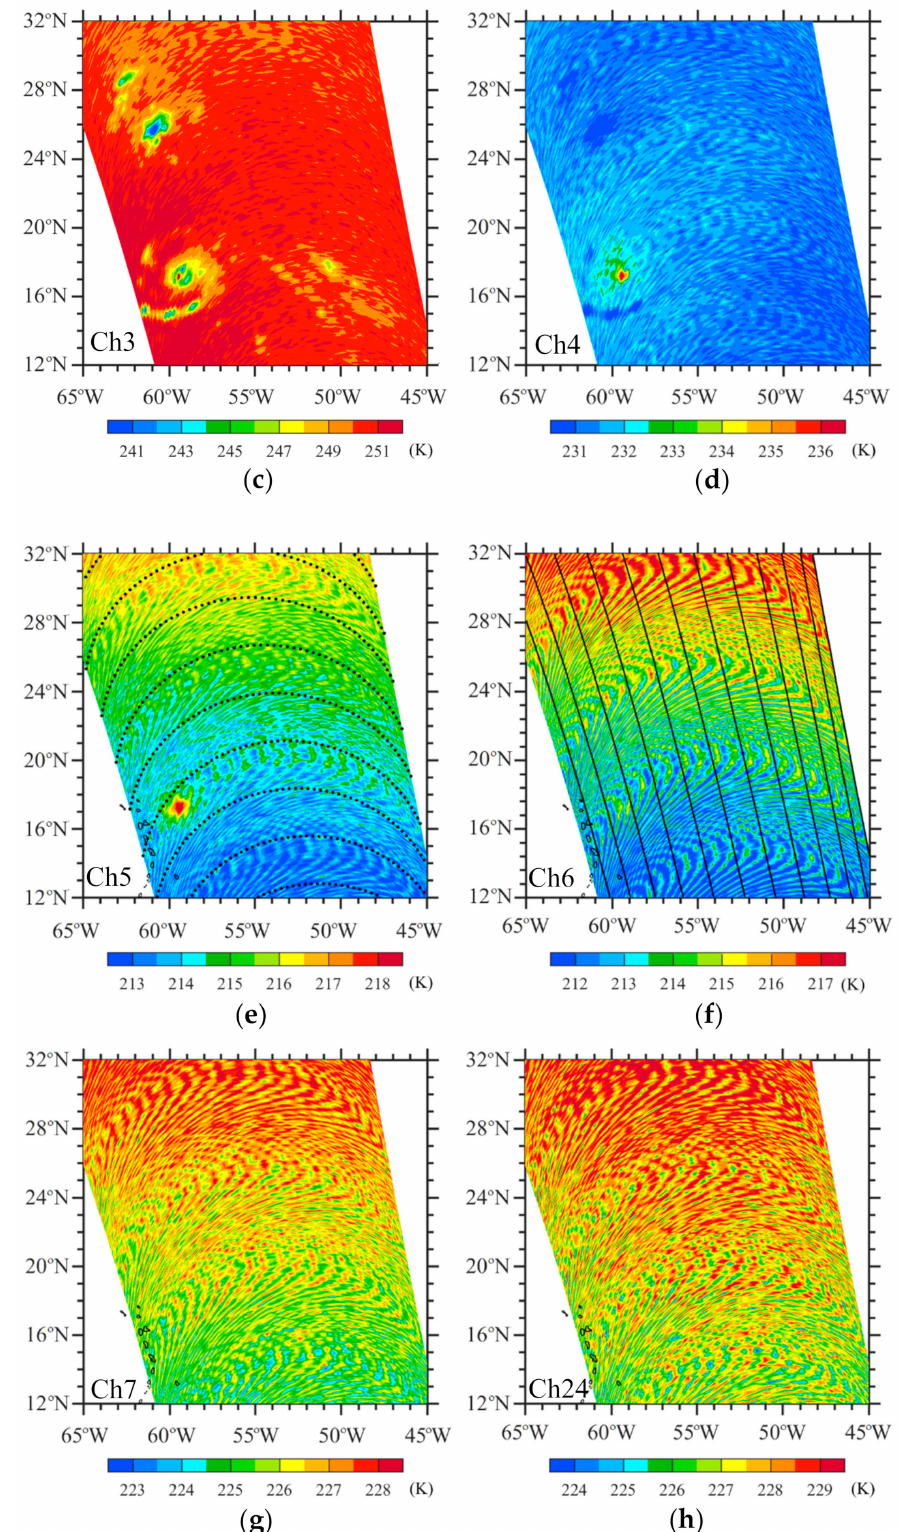
Figure 2. ( a – h ) TB observations of channels 1–7 and 24 on 5 September 2017. The across-track distributions of 60 FOVs along several SSMIS scanlines at an interval of 25 scanlines in ( e ) and the along-track distributions of FOVs at an interval of 5 FOVs in ( f ) are also shown. Hurricane Irma was located around 17.0 ◦ N, 59.7 ◦